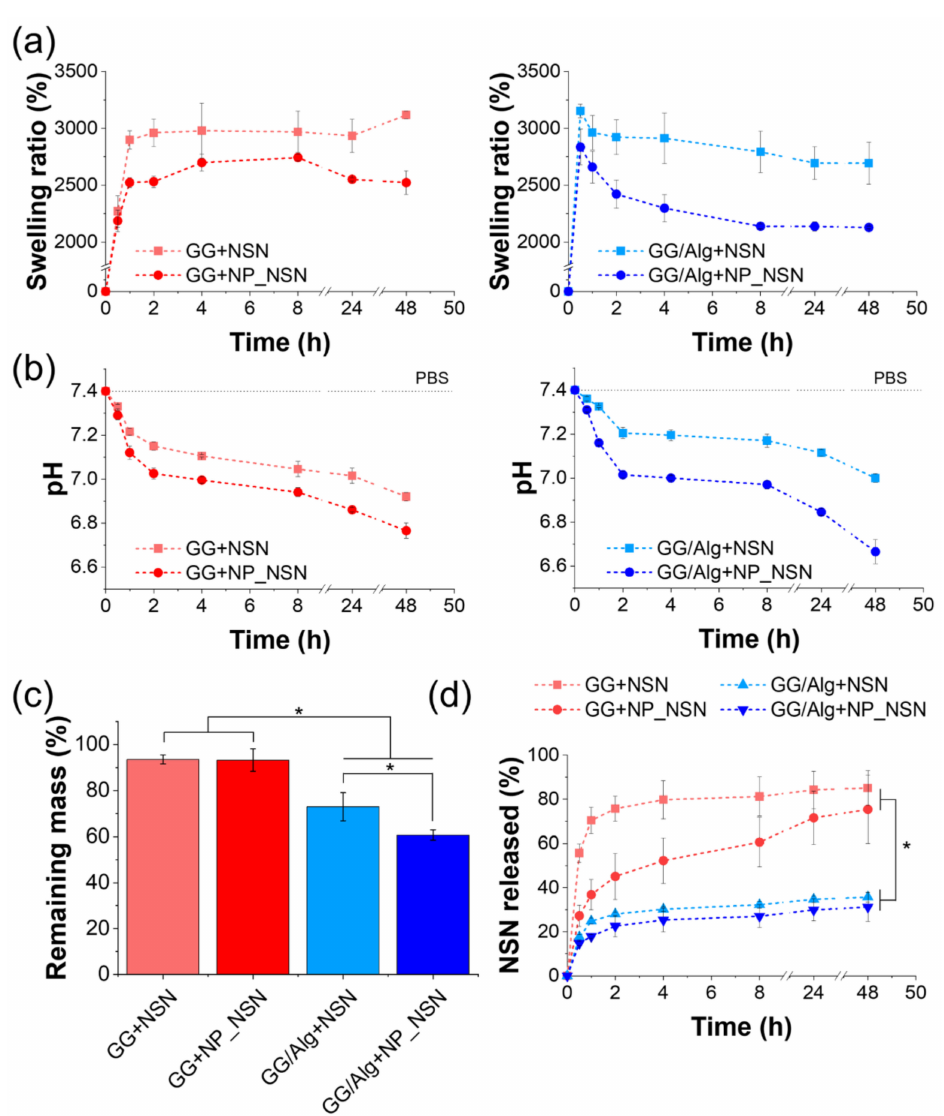
Figure 4. Swelling ratio ( a ) and pH change ( b ) during the incubation in PBS buffer, mass loss after 48 h of incubation ( c ) and NSN release profile ( d ) of GG and GG/Alg hydrogels containing NSN or NP_NSN. Statistically significant differences at * p <